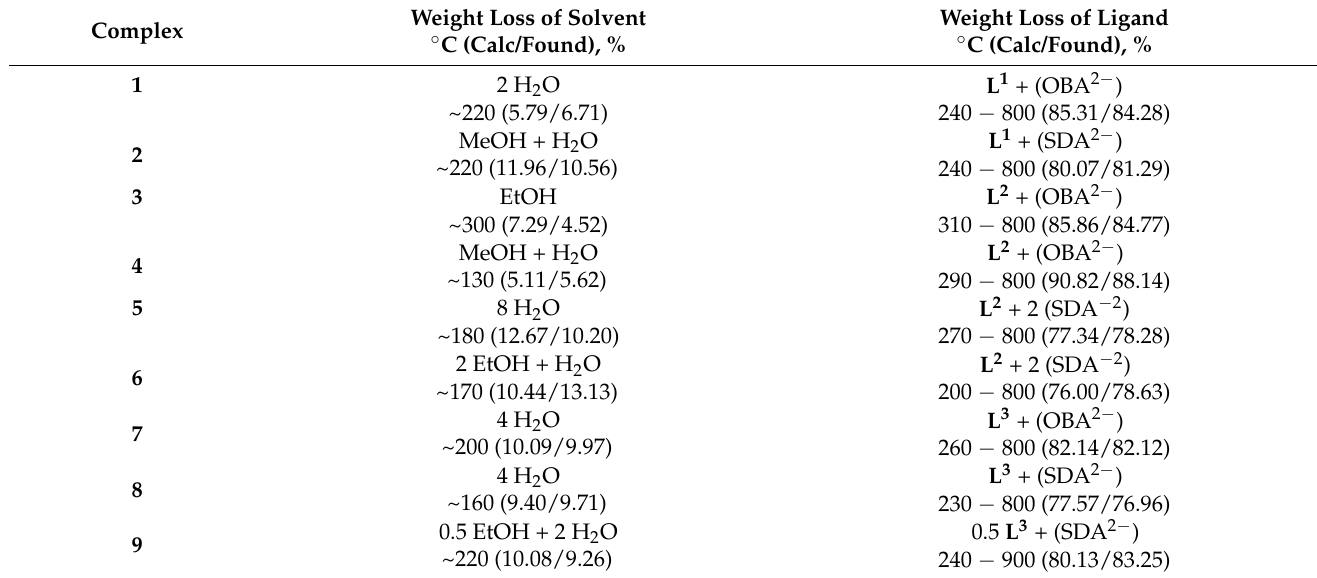
Table 2. Thermal properties of complexes 1 – 9